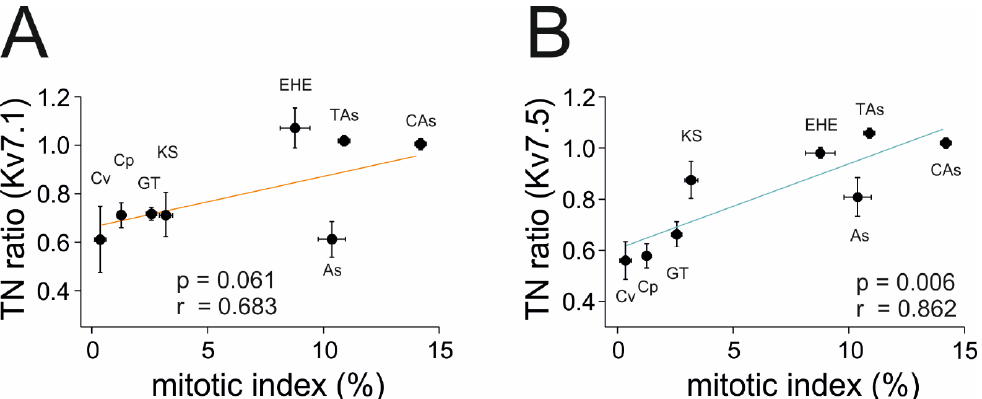
Figure 6. Kv7.1 and Kv7.5 expression according to tumor malignancy. Kv7.1 ( A ) and Kv7.5 ( B ) TN ratios (tumor-to-normal ratios) plotted against their mitotic index as a marker of the clinical aggressiveness of vascular tumors. A Pearson’s correlation coefficient of r = 0.683 with p = 0.061 indicates no apparent correlation between Kv7.1 expression and tumor aggressiveness. A Pearson’s correlation coefficient of r = 0.862 with p = 0.006 indicates a direct correlation between Kv7.5 expression and tumor aggressiveness. Values are the mean ± SEM. Cv: cavernous angioma; Cp: capillary angioma; GT: glomus tumor; KS: Kaposi’s sarcoma; EHE: epithelioid haemangioendothelioma; As: angiosarcoma; TAs: